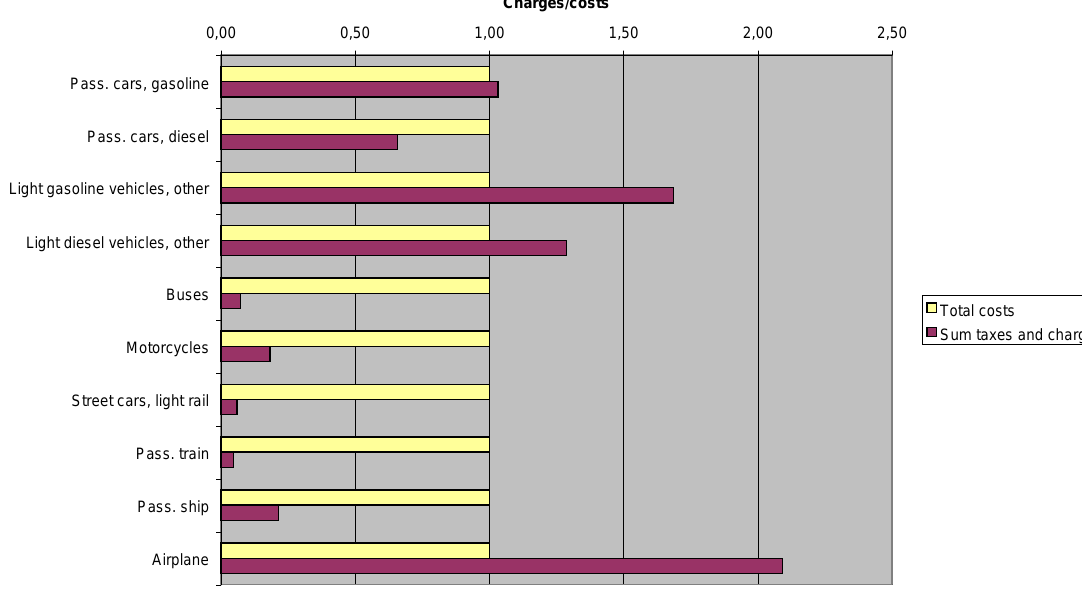
Figure 3. Marginal charges relative to external costs. Passenger